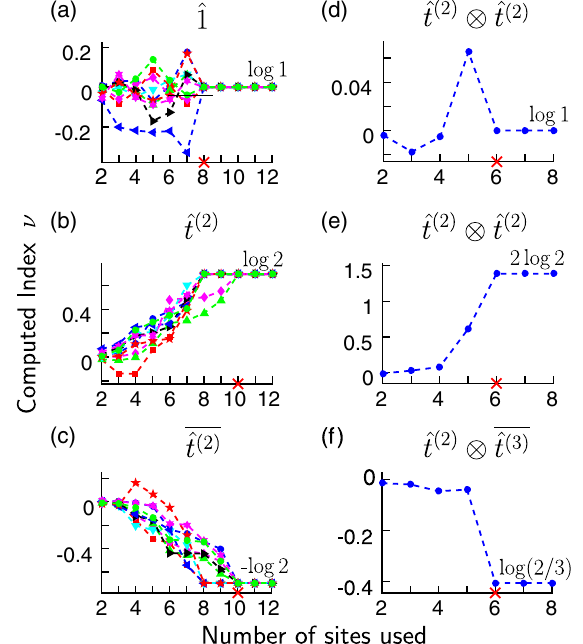
FIG. 5. Numerical evaluation of the chiral unitary index ν for different example MPUs. Each panel corresponds to the index ˆ F ˆ Y ˆ F calculation of a MPU taking the form , where is a random, ˆ Y disordered 1D FDLU, and is a MPU with a known index. The ˆ Y choice of is indicated on top of each panel. The horizontal axes indicate the total number of sites (in both the L and R intervals) used for the computation, and whenever the number is odd, R contains one more site than L . The dashed lines are guides for the eyes, and the red crosses on the horizontal axes indicate where the interval sizes reach the Lieb-Robinson lengths l . For each LR panel in (a – c), the index of the same disorder realization was computed using 10 randomly chosen cuts, indicated by the different markers. Each panel in (d – f) shows the index compu- tation at a single cut for a MPU. As shown in all panels, when the size of the intervals reaches l , the index computation con- LR verges to the expected value. (Please refer to Appendix D for details on the MPU